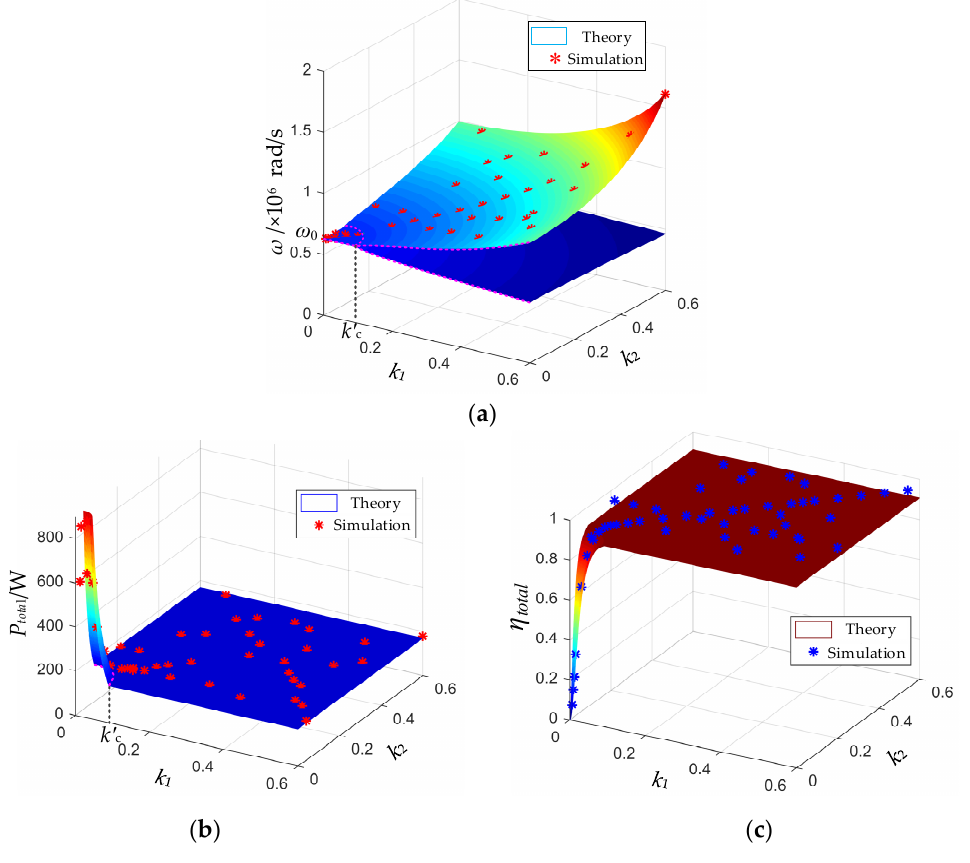
Figure 11. Transmission characteristics of double-load PT-WPT system: ( a ) operating angular frequency ω ; ( b ) total output power P total ; ( c ) total transfer efficiency η total .